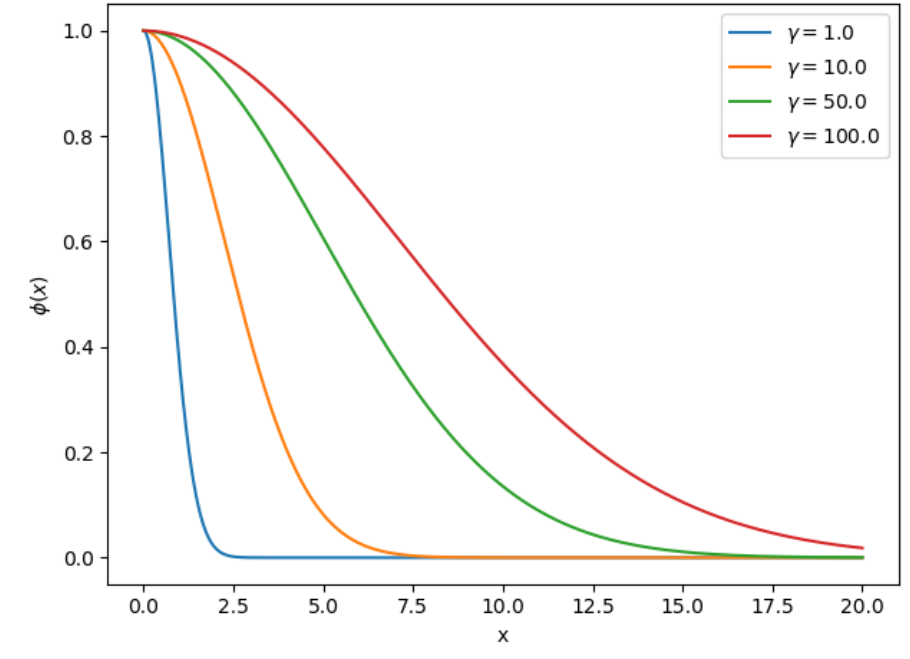
Figure 1. Radial Basis Function for different γ